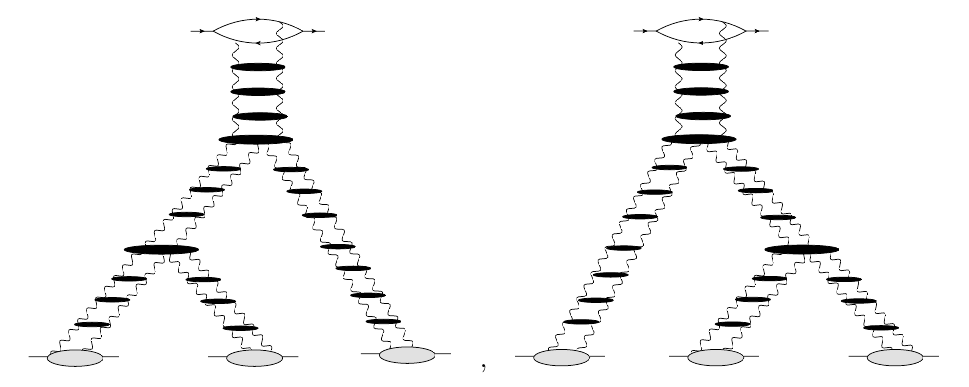
Figure 11 . Two more fan